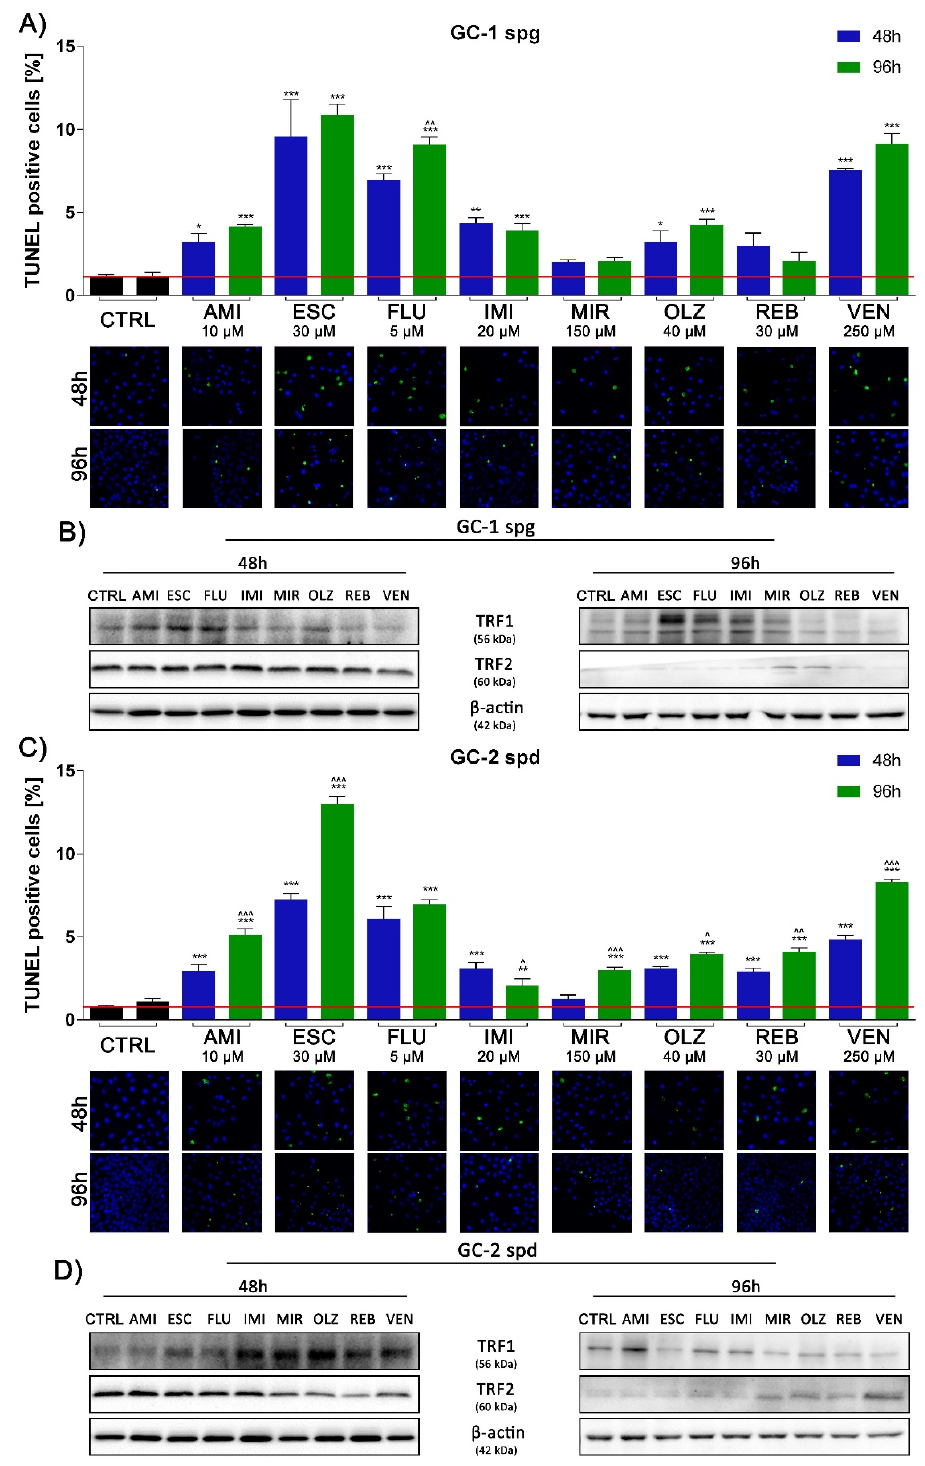
Figure 3. Toxic concentrations of antidepressants promote DNA fragmentation of treated cells.